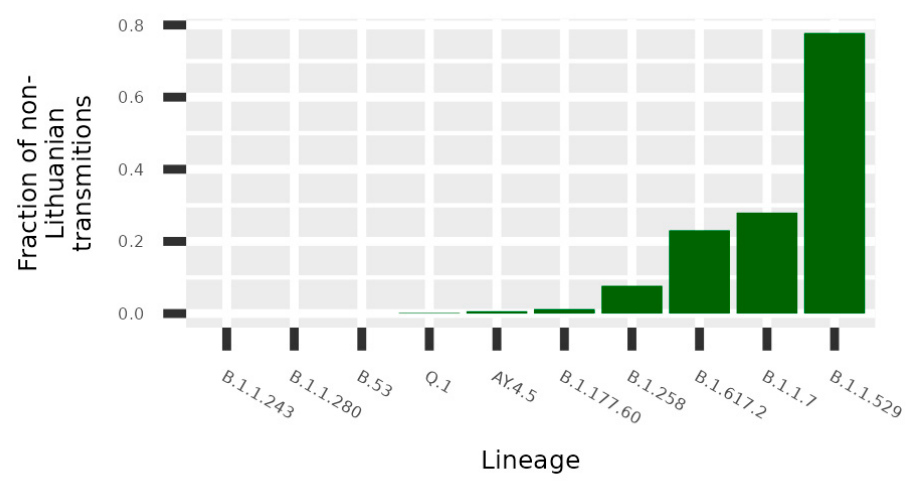
Figure 5. Potential non-Lithuanian origin transmissions. The figure indicates the fraction of sequences included in detected transmission clusters for which the most recent common ancestor is a non-Lithuanian sequence.